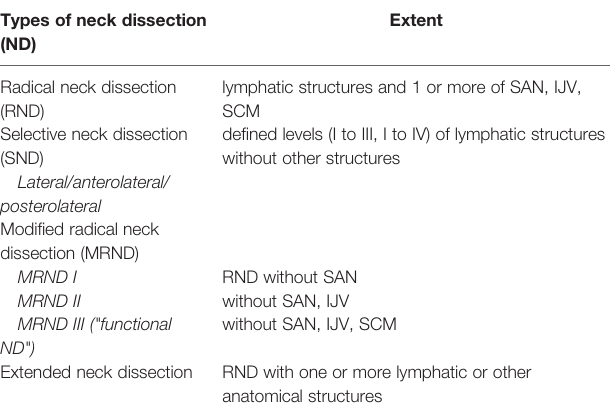
TABLE 2 | Types of ND according to Robbins and